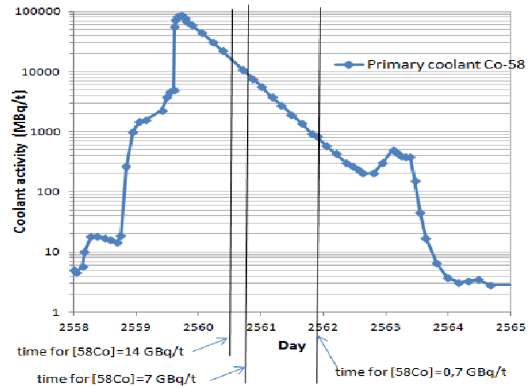
Fig. 4. Evolution of the activity of 58 Co in the primary coolant during a mid-cycle shutdown occurring 6 months before the end of